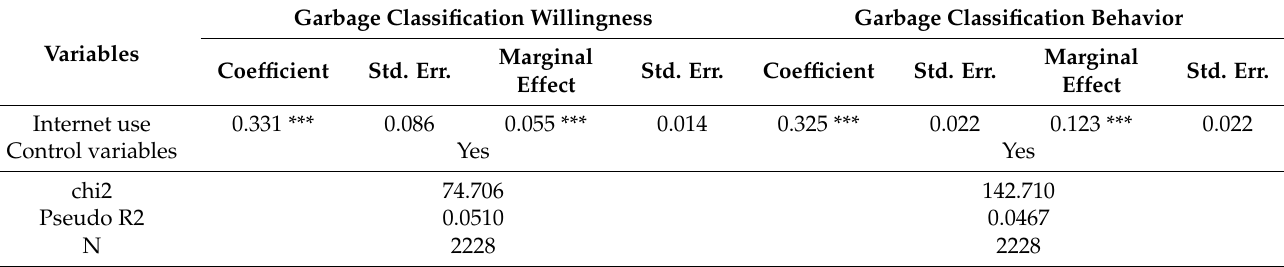
Table 5. Results of the robustness